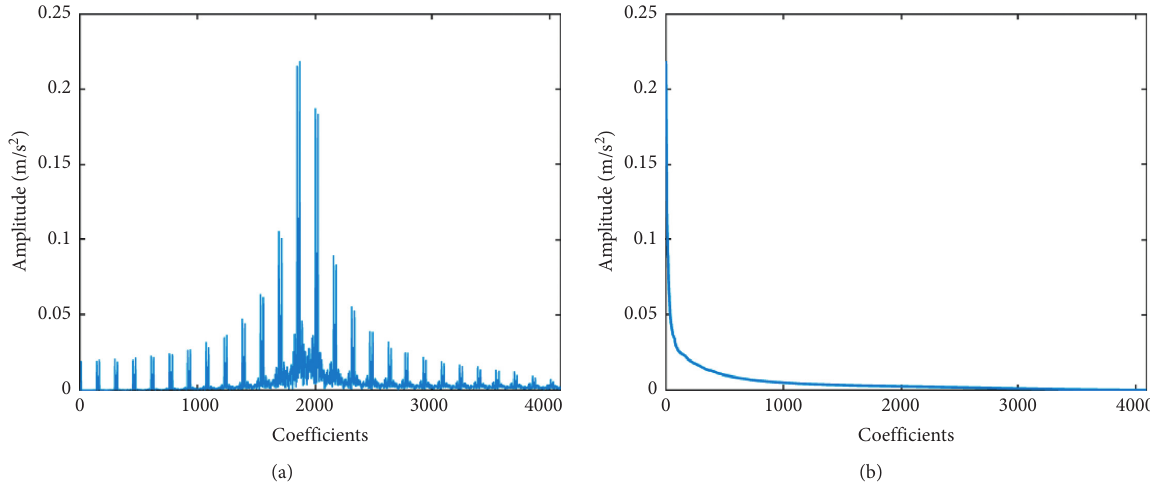
Figure 6: In Fourier dictionary, (a) sparse coefficients of pure simulation signal; (b) attenuation curve of (a).